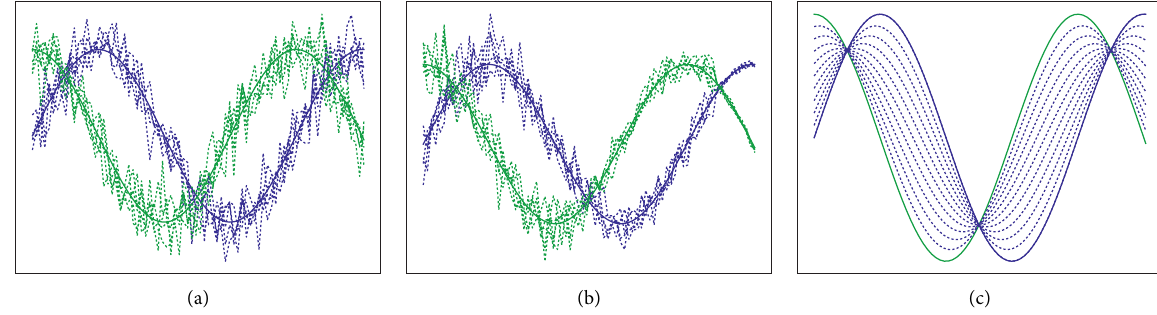
Figure 3: The transformed high-frequency components by (a) random noise, (b) our decay-scale noise operation, and (c) our interpolation operation.